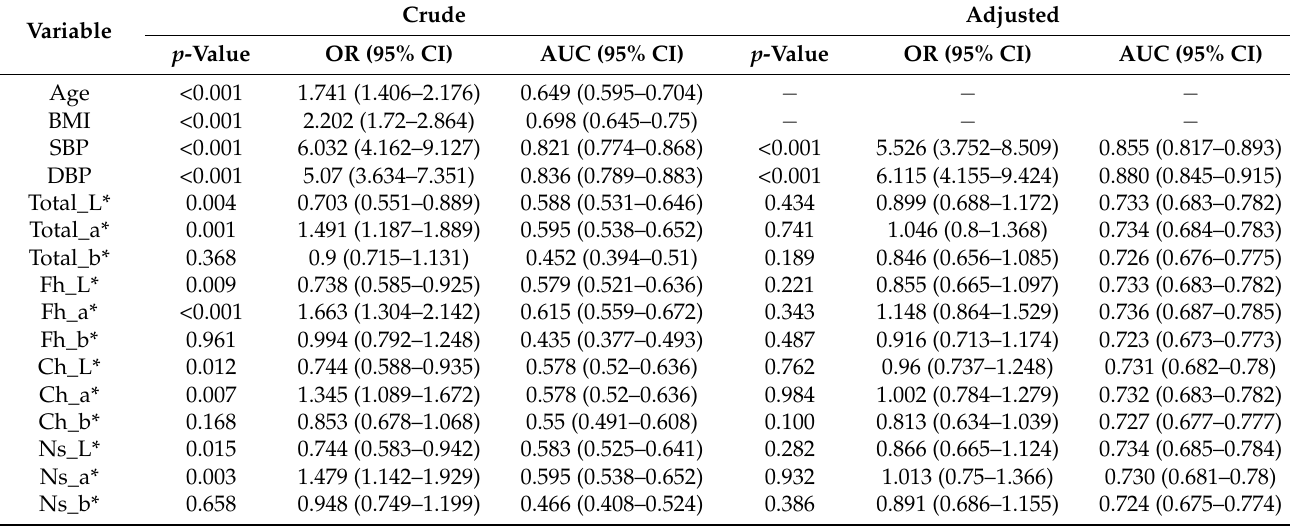
Table 3. The associations between individual complexion variables and hypertension in men with their predictive